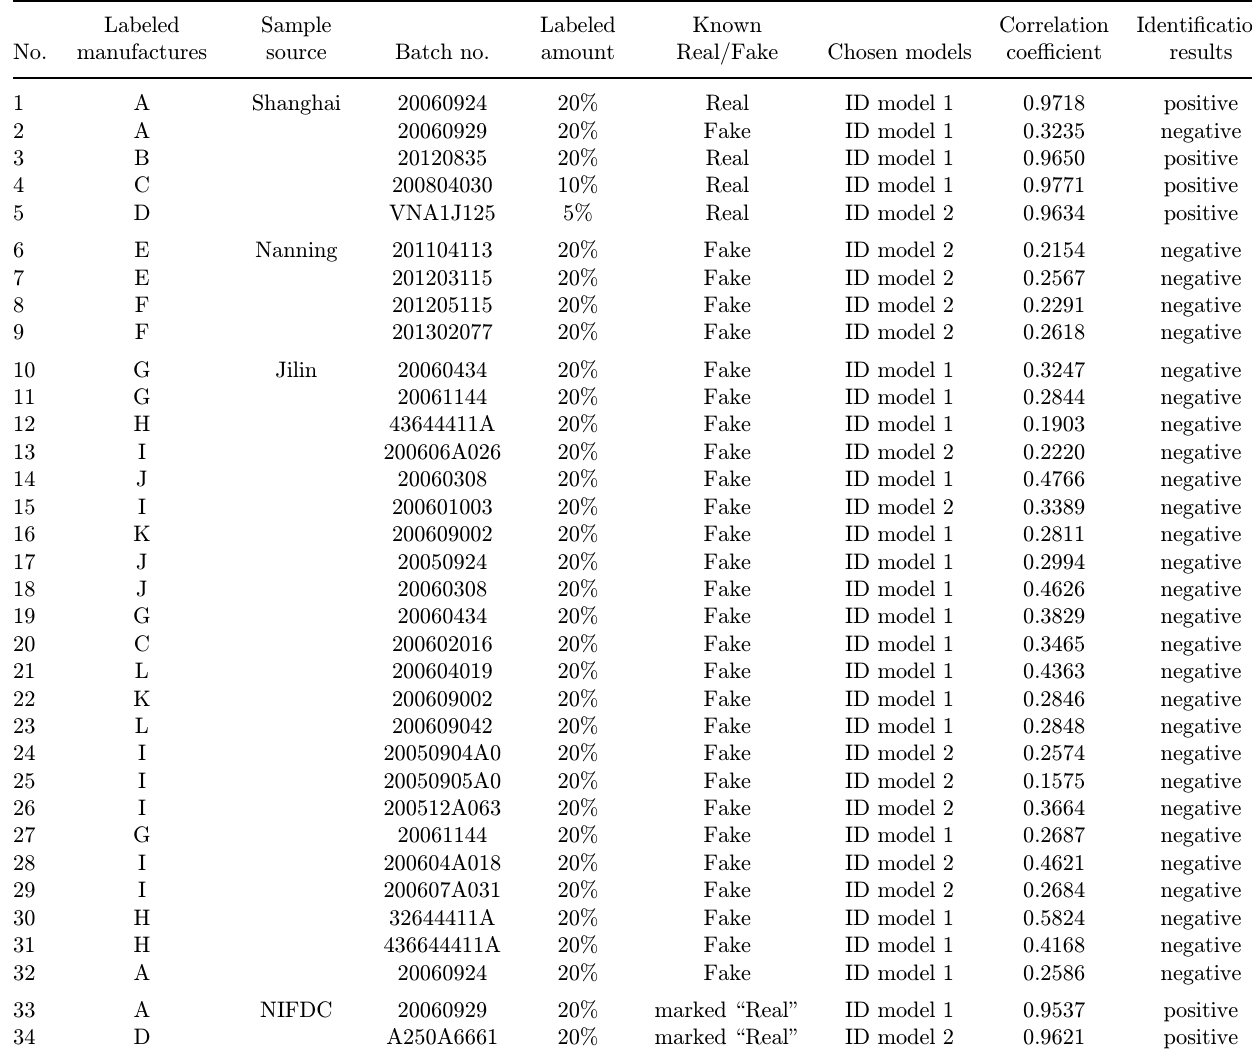
Table 3. Identi¯cation results of real and fake HSA injectatble products collected from the market.